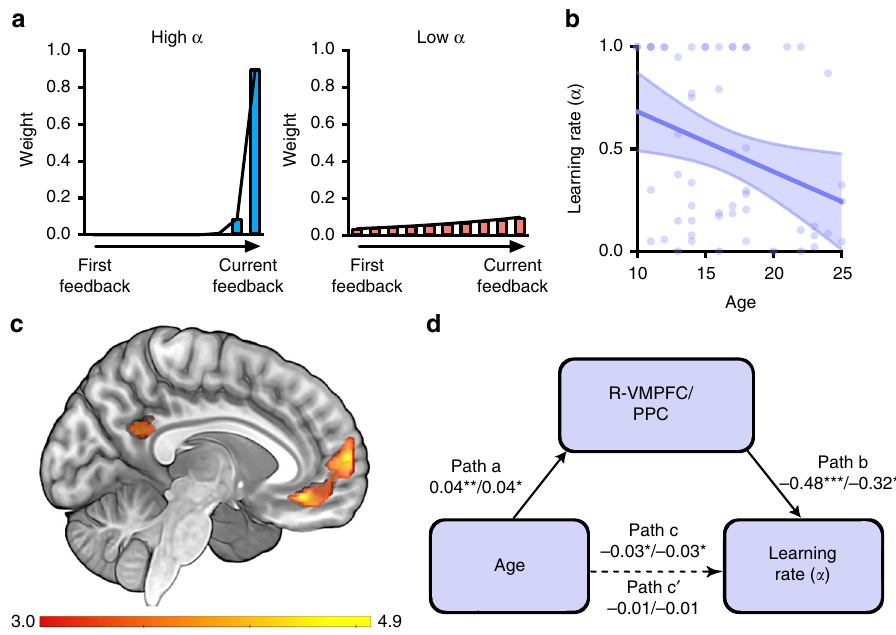
Fig. 4 Analyses with reinforcement learning (RL) model. a Illustration of the relationship between the learning rates (high and low) from RL model and differential impact of the current and previous feedback on partner-evaluation at the current trial (tenth trial in this illustration; for mathematical illustration, see Eq. (3)). b Negative association between age and learning rate. Purple circles, line, and band indicate individuals ’ learning rates, the best fi tted line and 95% con fi dence interval band, respectively. c Statistical parametric map depicting RMPFC extending into VMPFC (whole brain and SVC FWE < 0.05) signals and PPC (whole-brain FWE < 0.05) coding prediction error (PE) signals which were negatively associated with learning rate (see also Supplementary Table 2). d Age-related decrease in learning rate was mediated by the PE-related parametric modulation estimates of R-VMPFC and PPC ( c ). (Regression coef fi cients before and after the slash correspond to R-VMPFC and PPC, respectively. * p < 0.05, ** p < 0.01; Bootstrapping